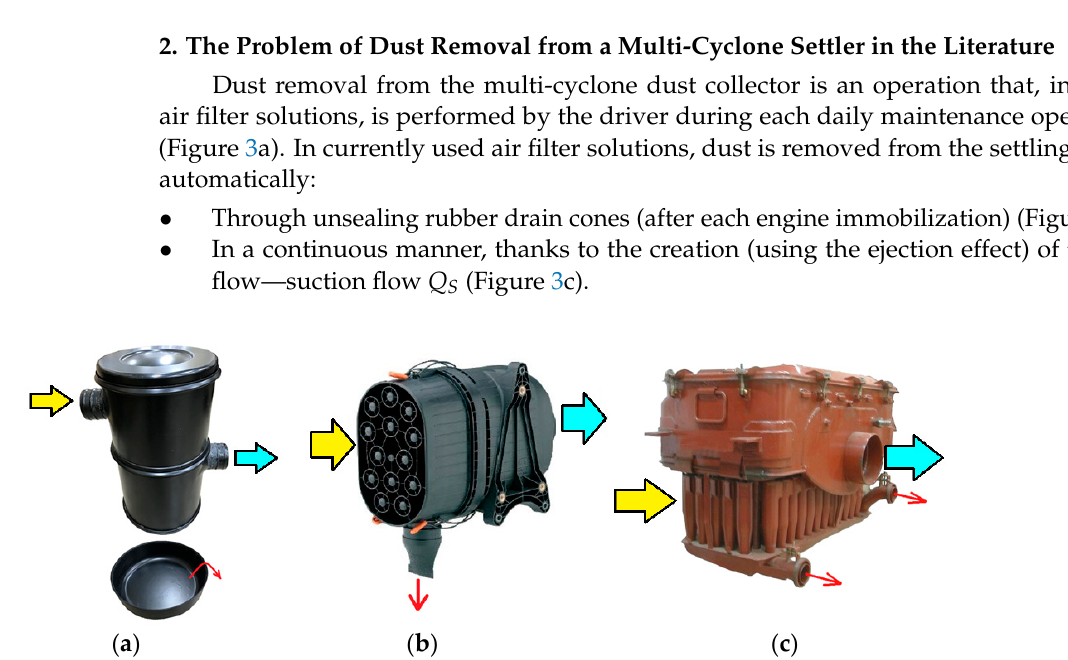
Figure 3. The manners of dust removal from the multi-cyclones: ( a ) manually (filter of combine harvester engine), ( b ) with a rubber drain cone (Mann + Hummel filter), ( c ) ejectively (filter of military tracked vehicle).